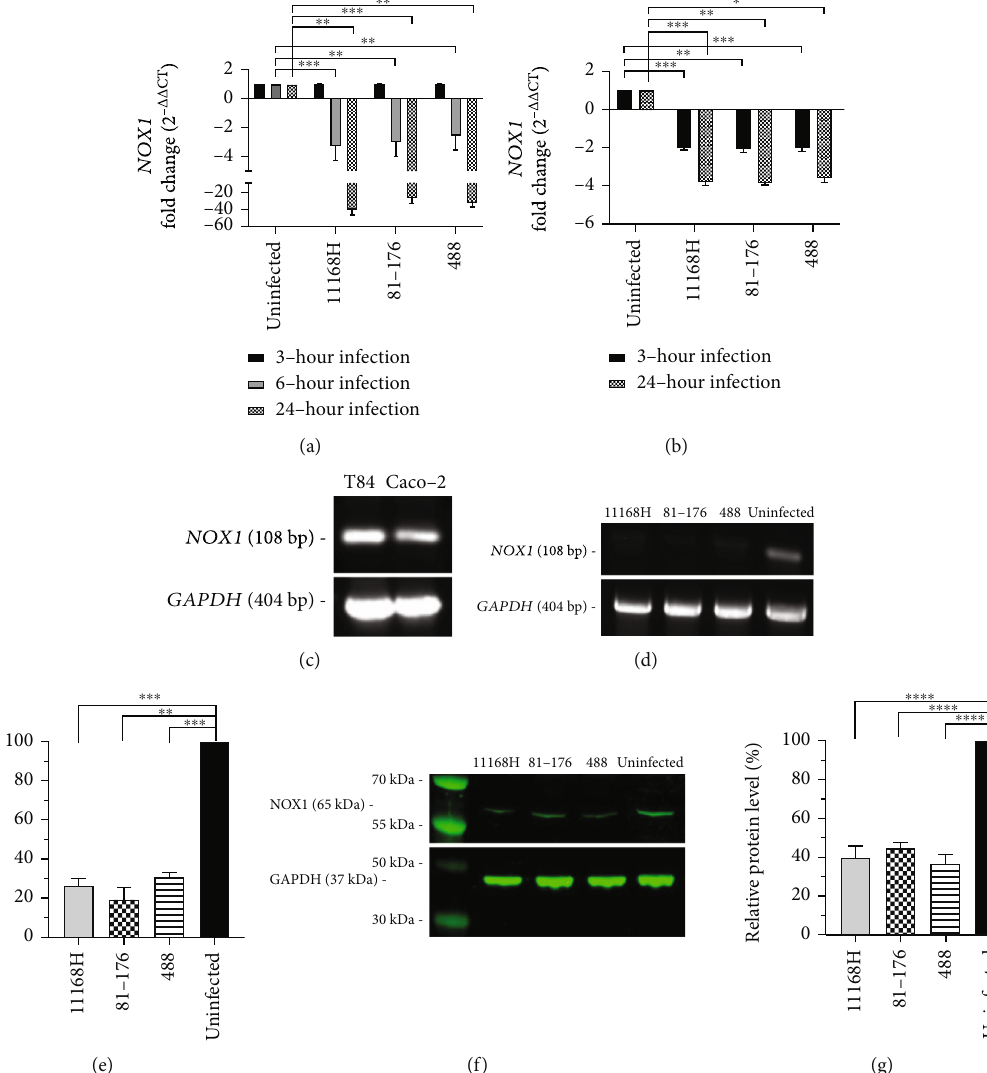
Figure 2: C. jejuni modulates NOX1 expression in T84 and Caco-2 cells. qRT-PCR showing expression of NOX1 in (a) T84 and (b) Caco-2 cells. (c) RT-PCR showing expression of NOX1 in uninfected T84 and Caco-2 cells. GAPDH was used as an internal control. (d) RT-PCR showing expression of NOX1 in T84 cells infected with C. jejuni for 24 hours and (e) relative mRNA levels as a percentage from RT-PCR data. (f) Western blotting showing NOX1 in T84 cells infected with C. jejuni for 24 hours and (g) relative protein level as a percentage from Western blotting. Asterisks denote a statistically signi fi cant di ff erence ( ∗ p < 0 : 05 ; ∗∗ p < 0 : 01 ; ∗∗∗ p < 0 : 001